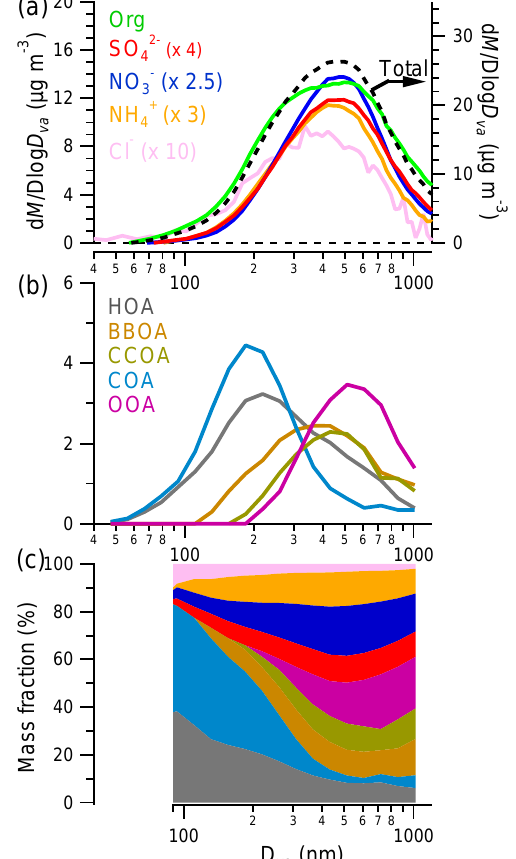
Figure 3. The size distributions of (a) NR-PM 1 species, (b) organic components, and (c) mass contribution of all species to NR-PM 1 .